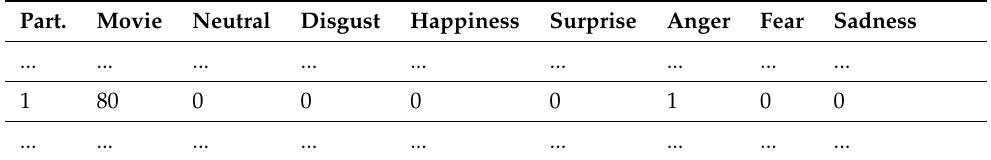
Table 6. Matrix row representing annotated emotions for the first participant watching the 80th video. Part. Movie